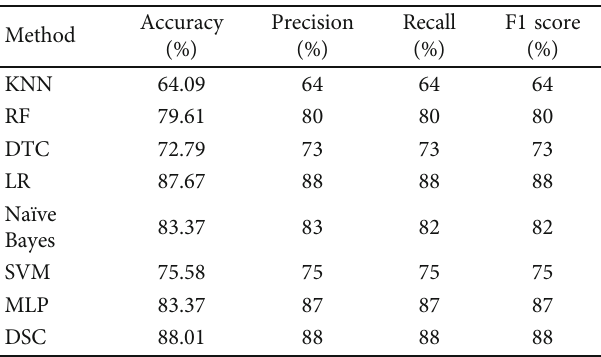
Table 9: A description of the performance metrics similar to baseline IMDB dataset classi fi ers.